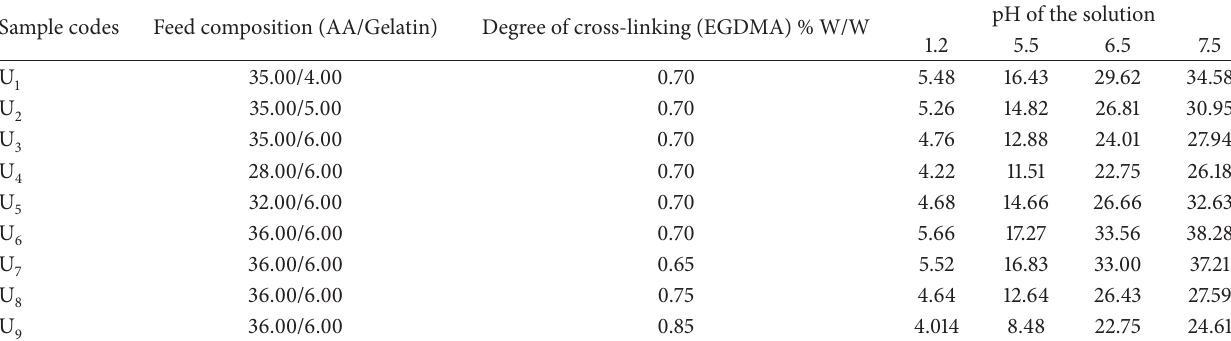
Table 2: Equilibrium swelling ratio of AA/Gelatin hydrogels.